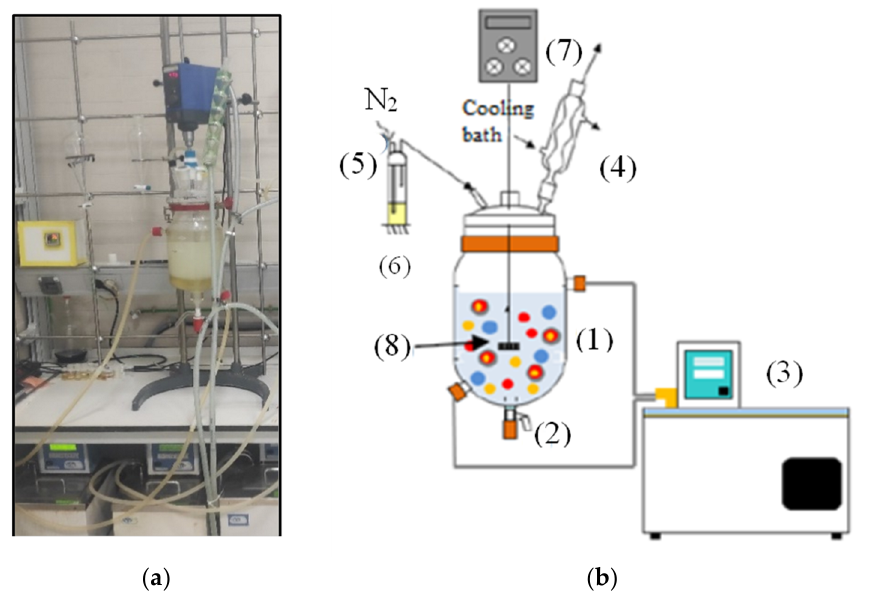
Figure 1. Experimental system for the polymerization process: ( a ) real view; ( b ) scheme: (1) reactor vessel, (2) vessel outlet, (3) heating bath, (4) reflux condenser, (5) nitrogen line, (6) scrubber, (7) digital stirrer and (8) six-bladed Rushton turbine impeller.